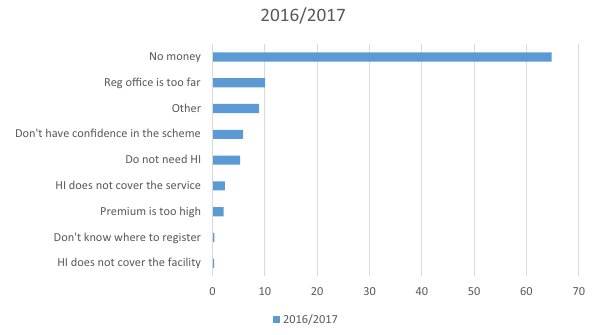
Fig. 4 Reasons for stopping to enroll. This Figure shows the percentages of the over 30% of all insured persons who had stopped enrolling, citing various reasons for dropping